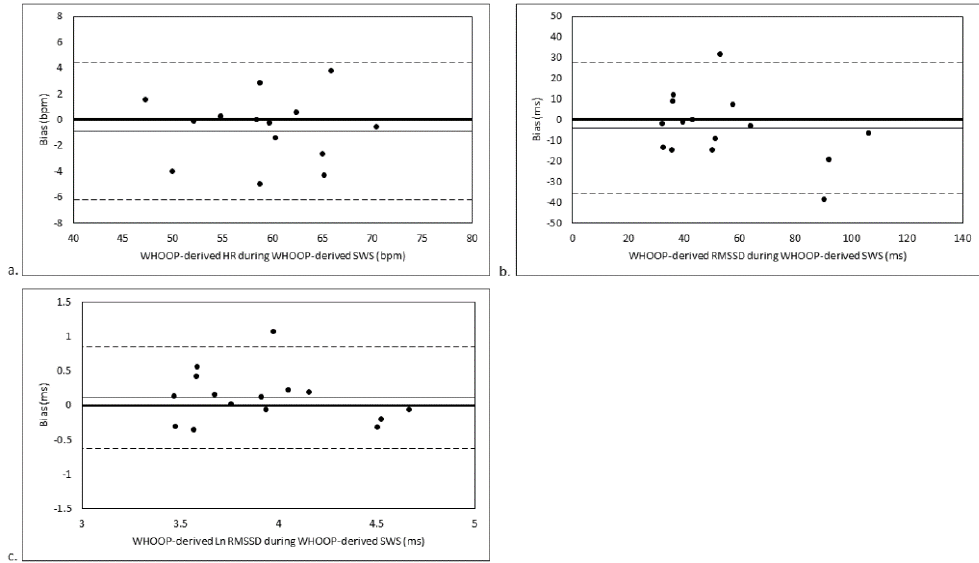
Figure 3. Agreement between ( a ) WHOOP-derived HR during PSG-derived SWS and WHOOP-derived HR during WHOOP-derived SWS, ( b ) WHOOP-derived RMSSD during PSG-derived SWS and WHOOP-derived RMSSD during WHOOP-derived SWS, and ( c ) WHOOP-derived Ln RMSSD during PSG-derived SWS and WHOOP-derived Ln RMSSD during WHOOP-derived SWS. Bias is calculated as WHOOP-derived variable during WHOOP-derived SWS minus WHOOP-derived variable during PSG-derived SWS. Thin continuous line represents mean bias. Dashed lines represent mean bias ± limits of agreement. bpm, beats per minute; HR, heart rate; Ln RMSSD, natural logarithm of the root mean square of successive BB interval differences; ms, milliseconds; PSG, polysomnography; RMSSD, root mean square of successive BB interval differences; SWS, slow-wave sleep.